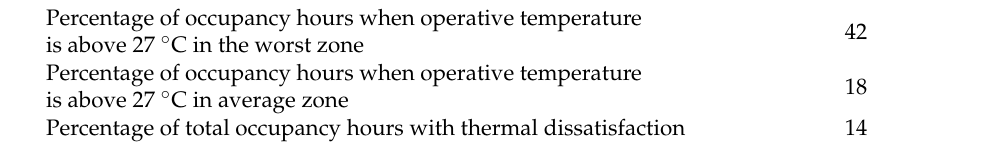
Table 9. Overall thermal comfort status in case